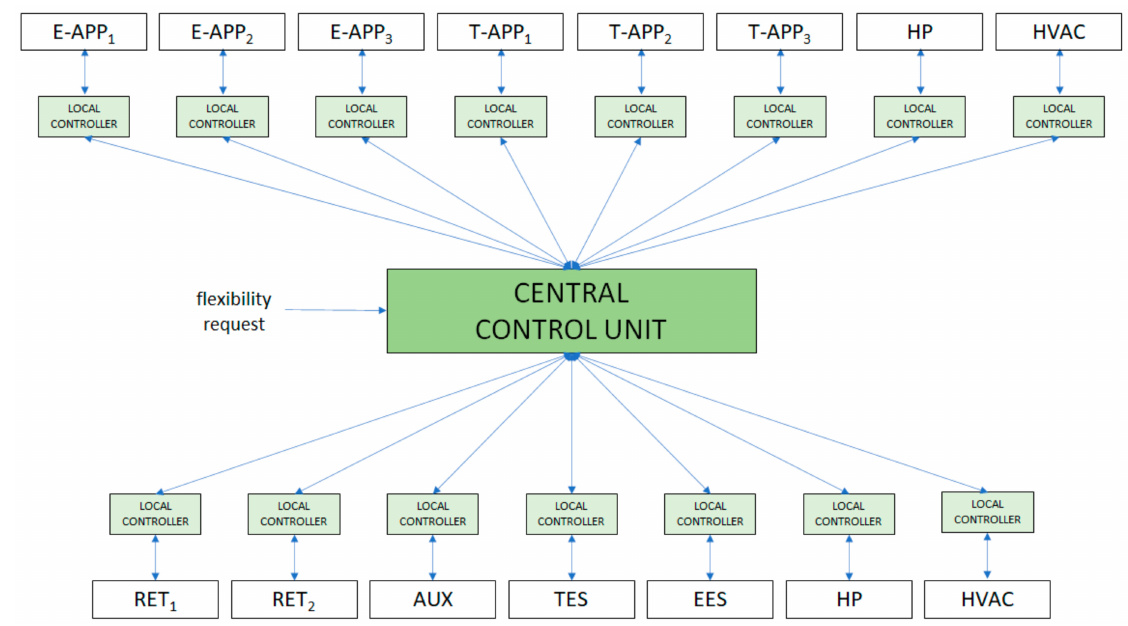
Figure 11. Centralized control architecture.